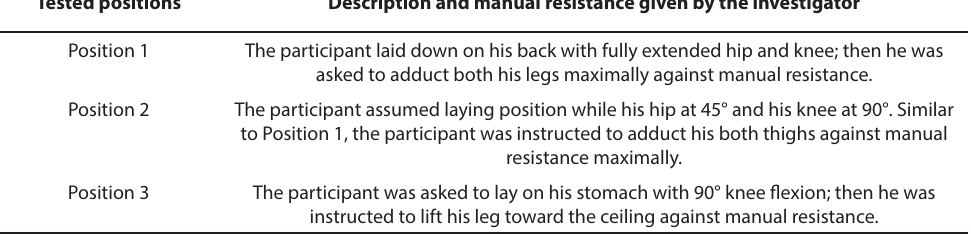
TABLE 1. Description of testing